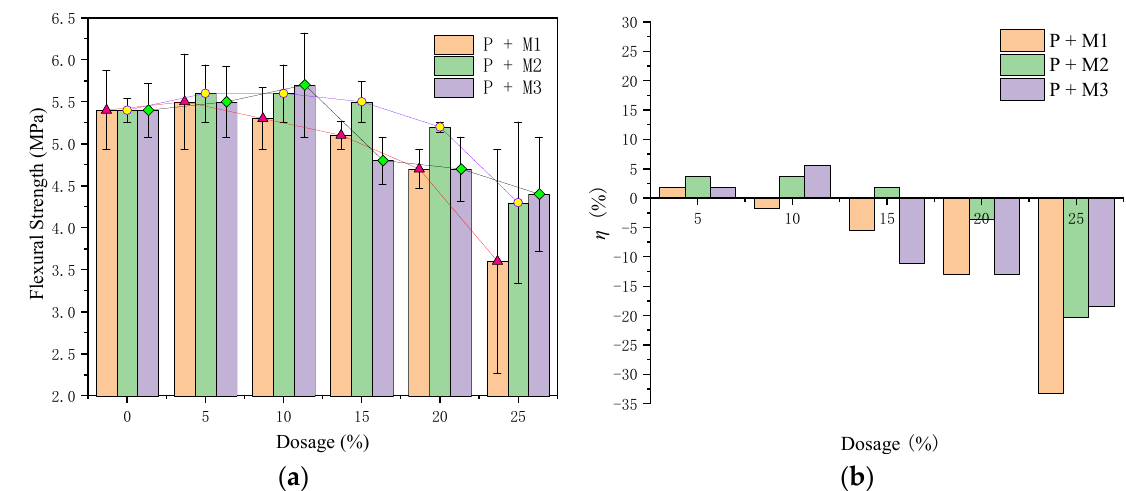
Figure 7. Results of 3 d of flexural strength. ( a ) Flexural strength. ( b ) Efficiency of action.